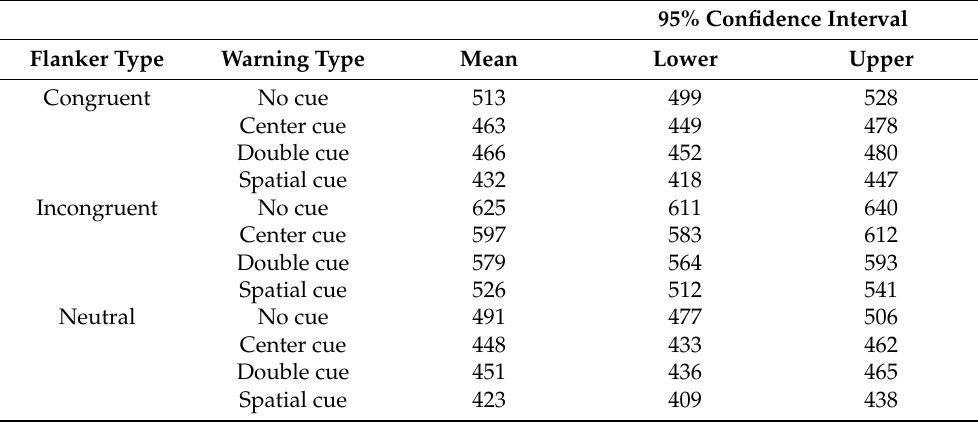
Table 1. Mean of median RT in ms for combinations of Warning type and Flanker type in the ANT task.